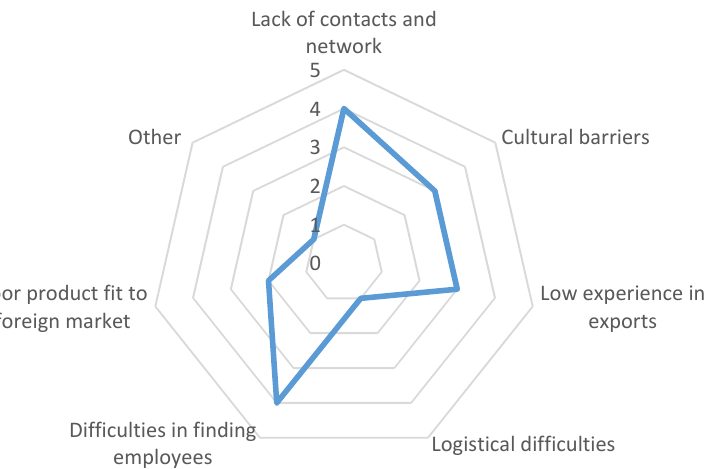
Figure 3. Factors restricting the expansion of FinTech companies into foreign markets (except regulation); 1 = not restrictive, 7 = extremely restrictive, medians.